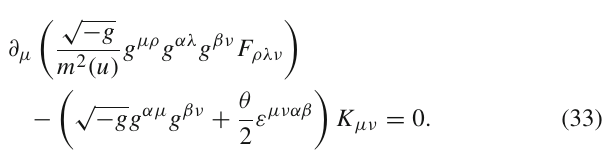
Fig. 8 Real and imaginary parts of the Hall AC conductivity as func- tions the θ -angle and the dimensionless frequency variable, w = 3 ω/ 4 π T , for C (cid:12) = (cid:12) L / 2 = 2 (dimensionless combination involv-